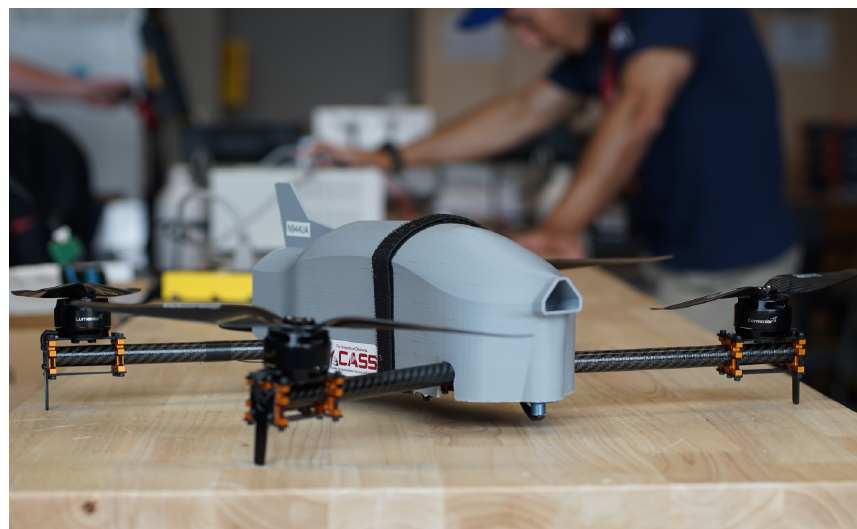
Figure 1. Angled front view picture of the ready-to-fly CopterSonde UAS.